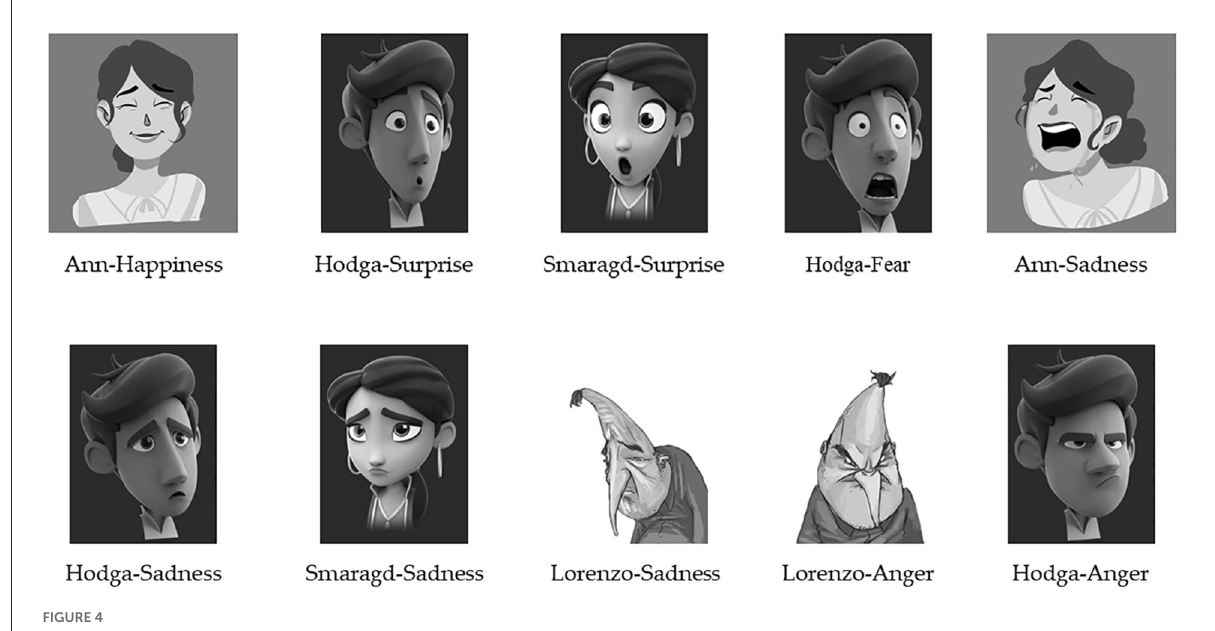
FIGURE4 Relevant character-emotion